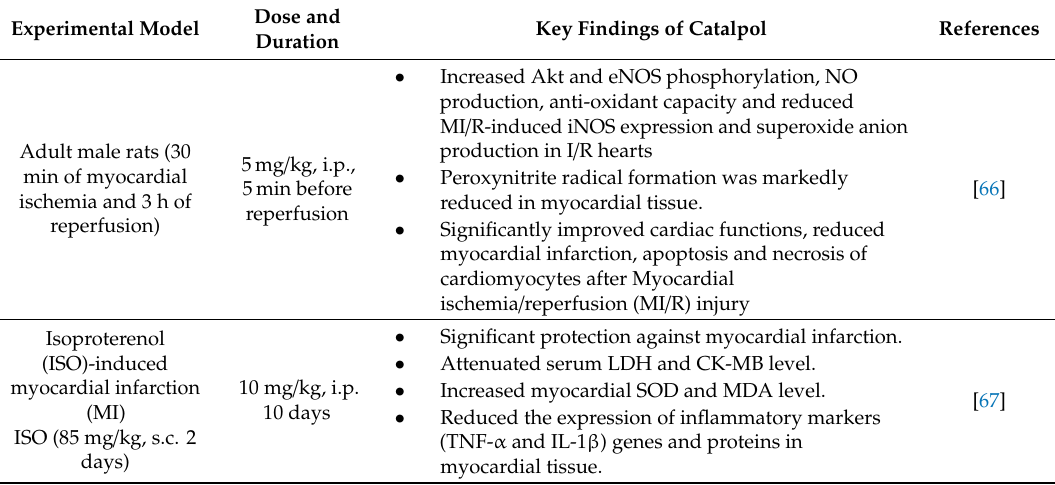
Table 4. E ff ect of catalpol in experimental models of cardiovascular